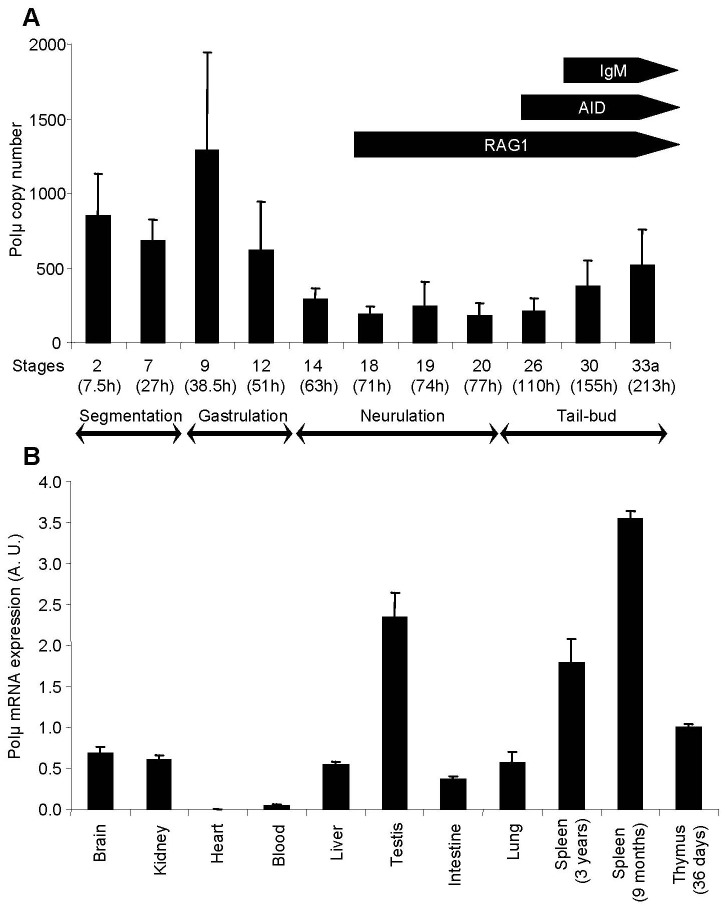

P. waltl polymerase µ mRNA expression profiles.Polµ transcripts were quantified by real-time PCR during early stages of development (A) and in various tissues (B). Arrows indicate the expression of AID, IgM heavy chains and RAG1 transcripts, as reported in previous studies [4], [6]. Developmental stages, as well as the time elapsed since laying (between brackets), are indicated. Ten embryos were studied for each developmental stage. The relative value obtained for the thymus of stage 44 larvae was set to 1 as a reference for tissue expression. Values represent means ± SEM.